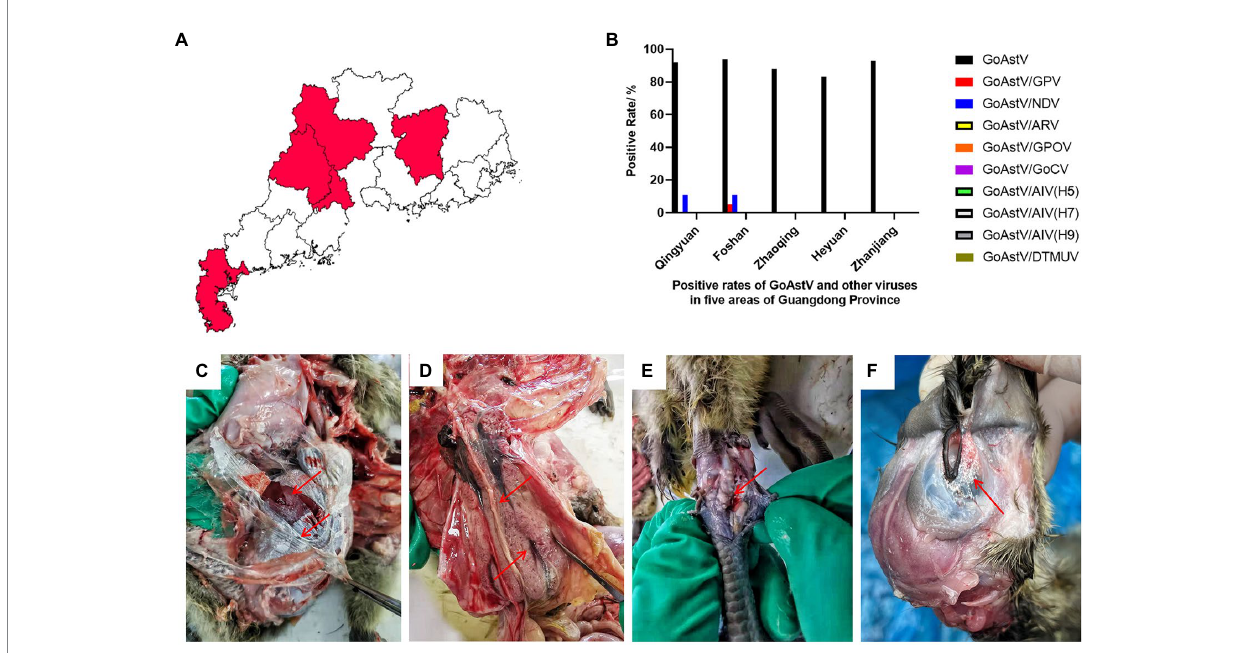
FIGURE 1 An epidemiological study was conducted with 94 clinical samples from five regions of South China. (A,B) Detection of GoAstV and other common viruses in five regions of South China. (B) The visceral surface of the abdominal cavity and the subcutaneous tissue capsule are covered by a large number of urate deposits. (C) Enlarged kidneys with hemorrhages and enlarged uteri with urate crystals filling the lumen. (D) Swollen joints with urate in the joint cavity. (E) The orbit is surrounded by urate deposits. (F) The edge of the orbit is swollen and the orbit is covered with white urate deposits.